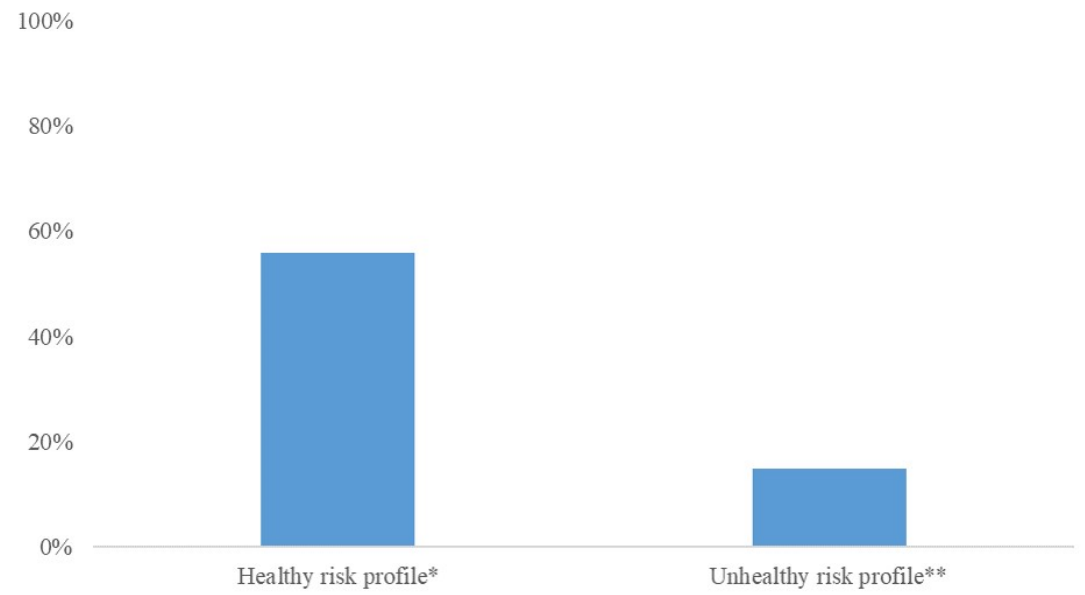
Figure 2. Chances of a healthy pregnancy outcome for women with different combinations of risk factors. * A health risk profile represents a 26-year-old women who is married, multiparous, a BMI of 26 kg/m 2 , 0.3 kg gestational weight gain per week, a mid-pregnancy systolic blood pressure of 110 mmHg, and a mid-pregnancy estimated fetal weight of 0.3 SDS. ** An unhealthy risk profile represents a 36-year-old women without a partner, nulliparous, a BMI of 40 kg/m 2 , 1 kg gestational weight gain per week, a mid-pregnancy blood pressure of 140 mmHg, and a mid- pregnancy estimated fetal weight of 1.5